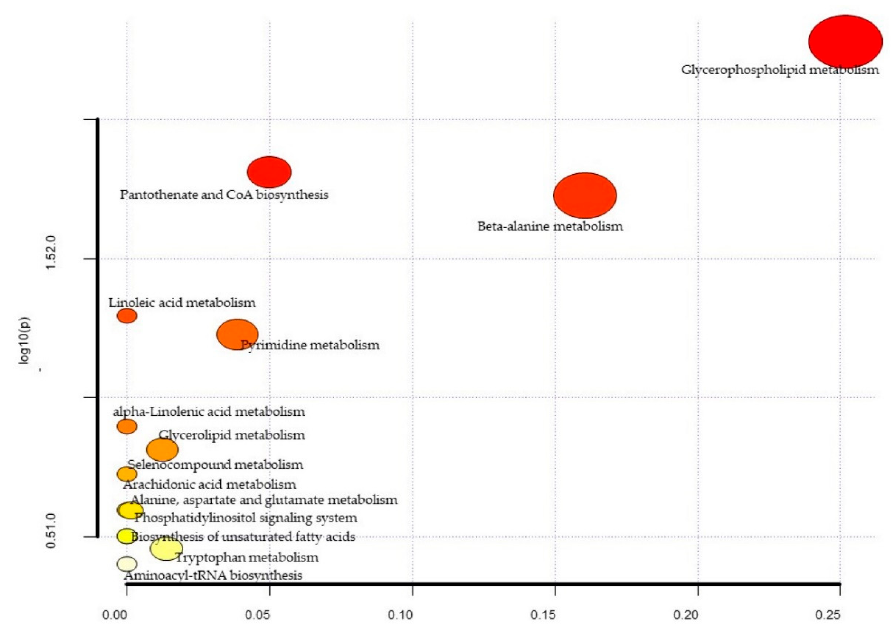
Figure 2. Metabolic pathway analysis for female patients. The x -axis represents the pathway impact, while the y- axis represents the − log ( p ). The analyzed pathway showed the metabolic network reprogramming of female ischemic patients with detailed impact.